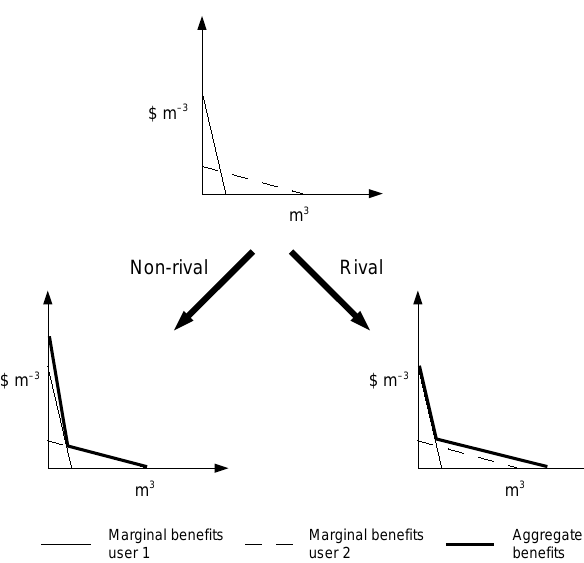
Figure 2. Aggregation of demand curves for rival and non-rival wa- ter uses for a given time